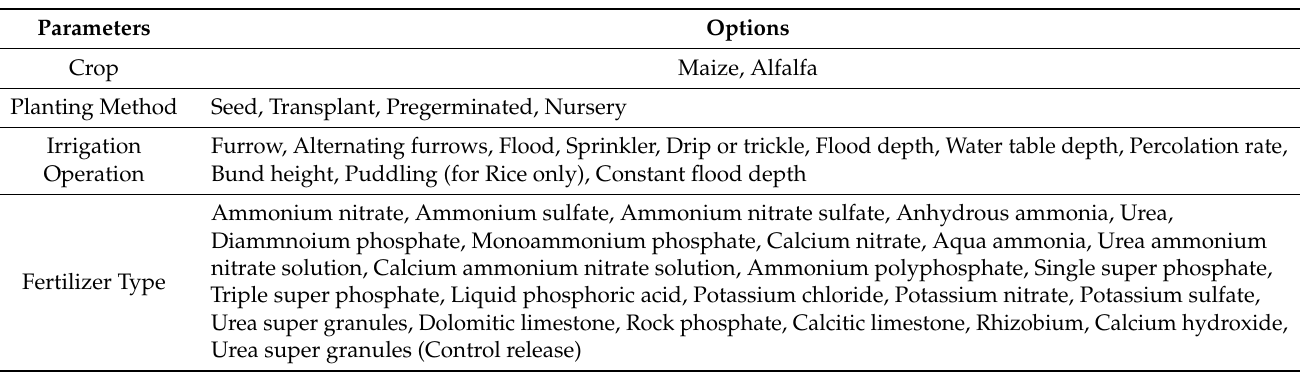
Table A1. Options for input parameters for